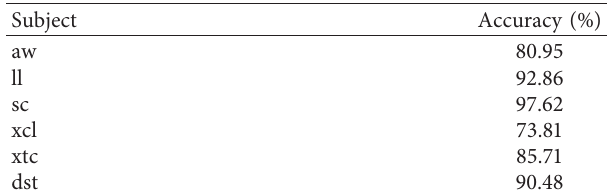
Figure 5: CNN in the WT-CNN Table 3: Main parameters of the WT-CNN model. Table 4: WT-CNN model classification results.